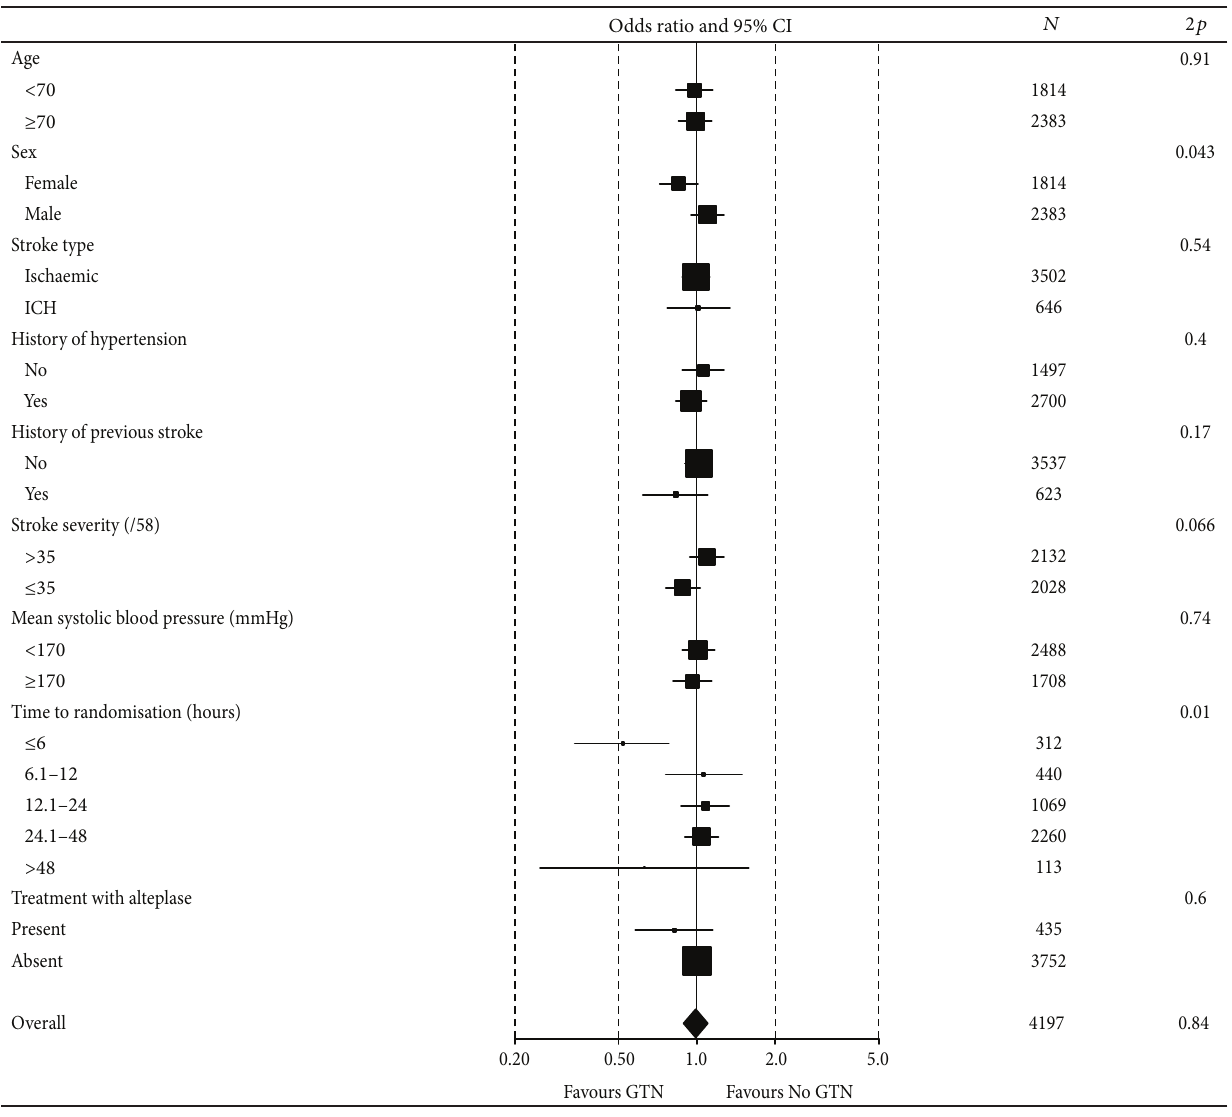
Figure 1: Effect of glyceryl trinitrate versus no glyceryl trinitrate on functional outcome (modified Rankin scale) at 90 days in predefined subgroups of patients. Analyses are